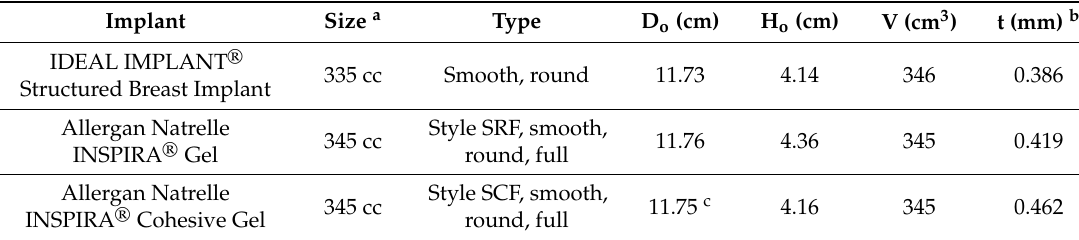
Table 3. Tested implants and their